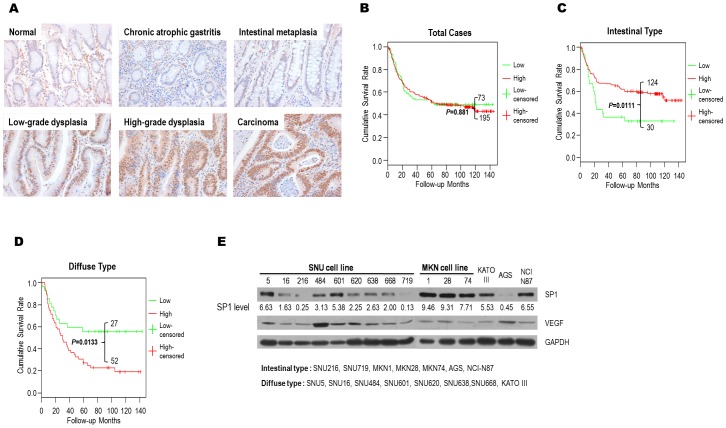
Immunohistochemical and survival analysis of SP1 expression in gastric cancer patients and SP1 expression in gastric cancer cell lines.A) The expression of SP1 increases with tumor progression from precancerous to malignant lesions. Positive staining is determined by a reddish-brown precipitate in the nuclei. B) The Kaplan-Meier survival probability with respect to SP1 expression levels in gastric carcinomas. Log-rank tests were performed to compare the survival of SP1 subgroups both within and between subtypes. C) The Kaplan-Meier survival probability with respect to SP1 expression levels in intestinal-type gastric carcinomas. Log-rank tests were performed to compare the survival of SP1 subgroups both within and between subtypes. P<0.05 was considered to be statistically significant. D) The Kaplan-Meier survival probability with respect to SP1 expression levels in diffuse-type gastric carcinomas. Log-rank tests were performed to compare the survival of SP1 subgroups both within and between subtypes. P<0.05 was considered to be statistically significant. E) The SP1 expression in 15 gastric cancer cell lines was measured by western blot analysis. The numbers indicate semi-quantified protein expression based on scanning densitometry normalized to GAPDH (a control). VEGF was also measured to compare its expression with SP1 in each cell type.